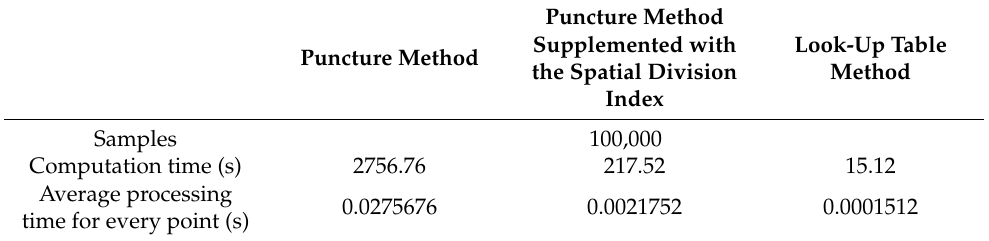
Table 8. The comparisons of grouping eight-segment layers using three different